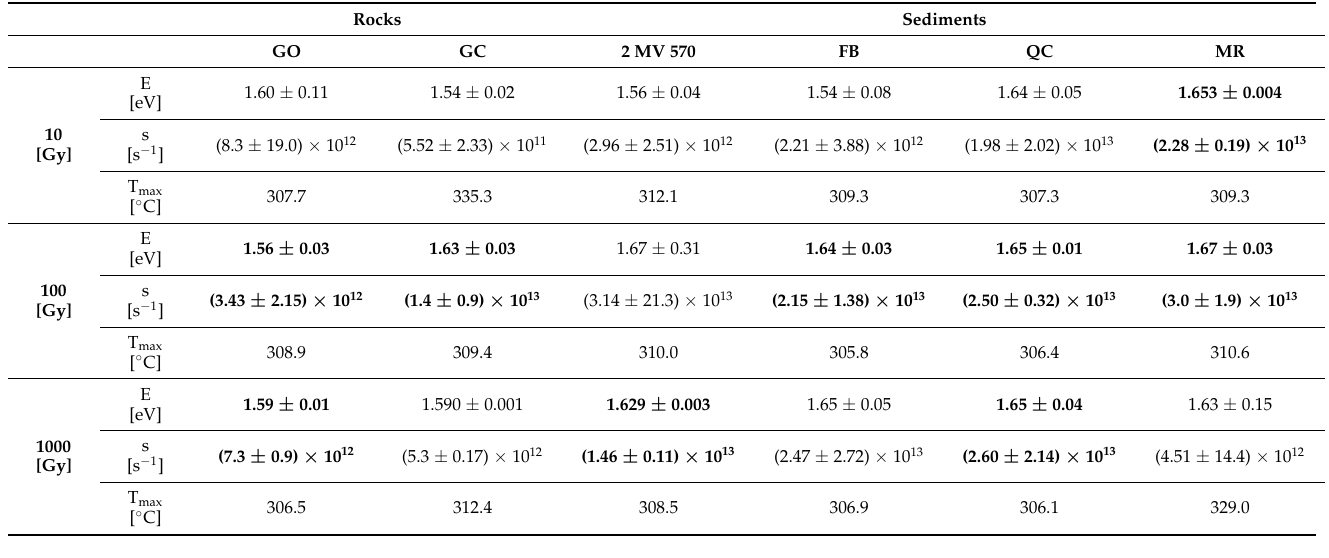
Table 2. Trap parameters values ( E and s ) obtained for various irradiation doses in OTDC experiment using TM-OSL 620 nm protocol for preheat 280 ◦ C. T max values are the maxima of TL peak positions simulated using first-order kinetic for adequate E , s and heating rate of 2 K/s.